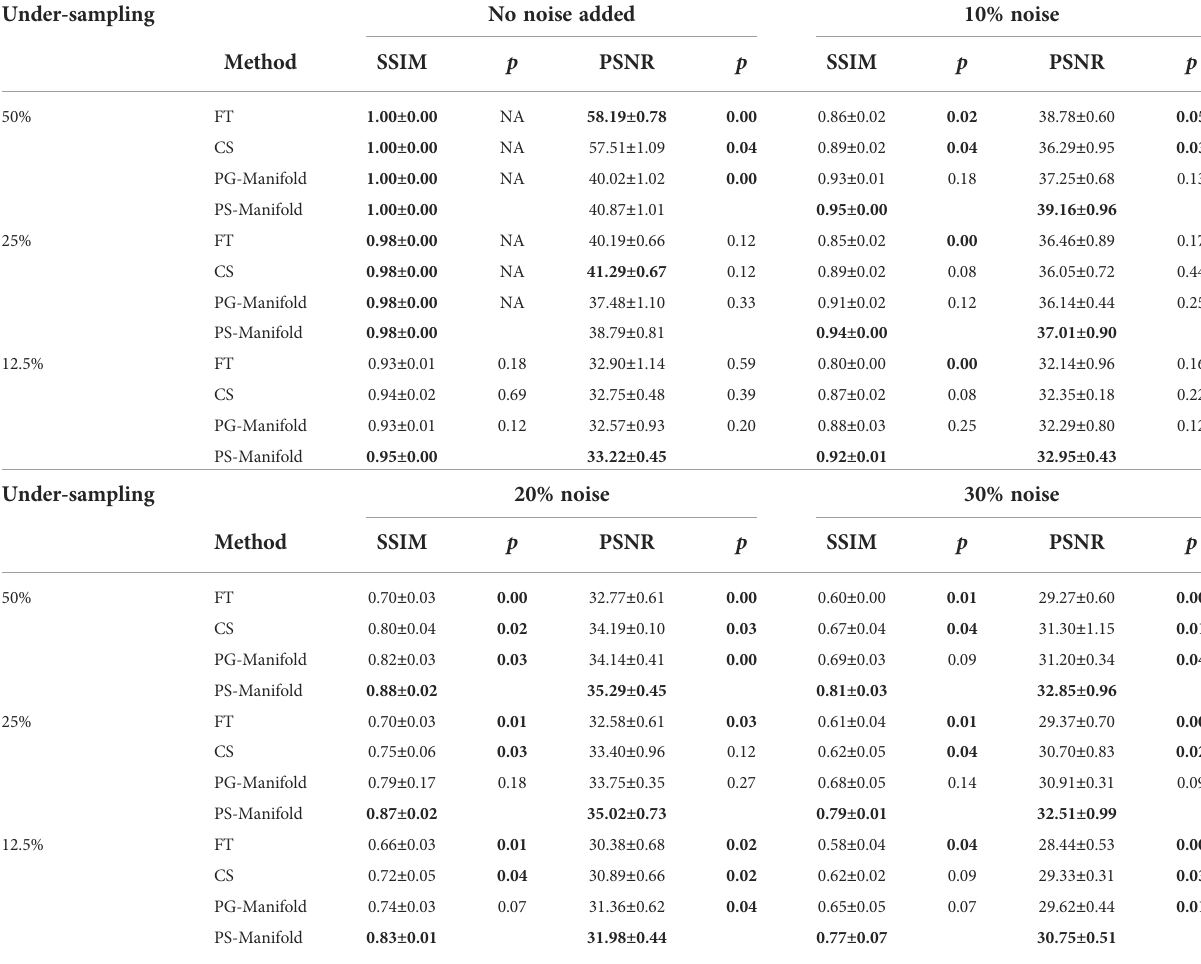
TABLE 1 Quantitative comparisons of FT, CS, patient-generic manifold, and patient-speci fi c manifold methods with different undersampling ratios and noise levels for three liver cases. Each number is the mean value ± standard deviation. The p-values between the proposed PS-Manifold and each method are included. The best result in each case and statistically signi fi cant p-values are highlighted with bold font. FT: Fourier Transform. CS: Compressive Sensing. PG-Manifold: Patient-generic manifold. PS-Manifold: Patient-speci fi c manifold.